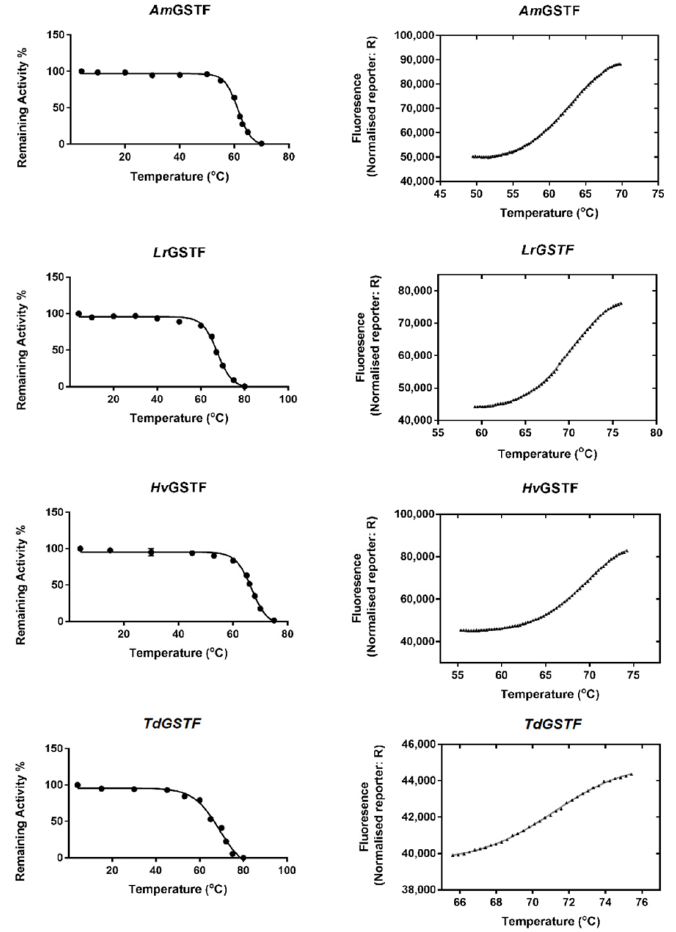
Figure 5. Thermal stability studies of the parent enzymes ( Am GSTF, Lr GSTF, Hv GSTF, Td GSTF). Left column: thermal inactivation curves. The remaining enzyme activities (%) were measured after heat treatment of each enzyme at the indicated temperatures ( ◦ C) for 5 min. Right column: Differential scanning fluorimetry normalised curves for the determination of the melting temperature (T m ). The measurements were performed in triplicate and the data represent the mean ± SD (N =